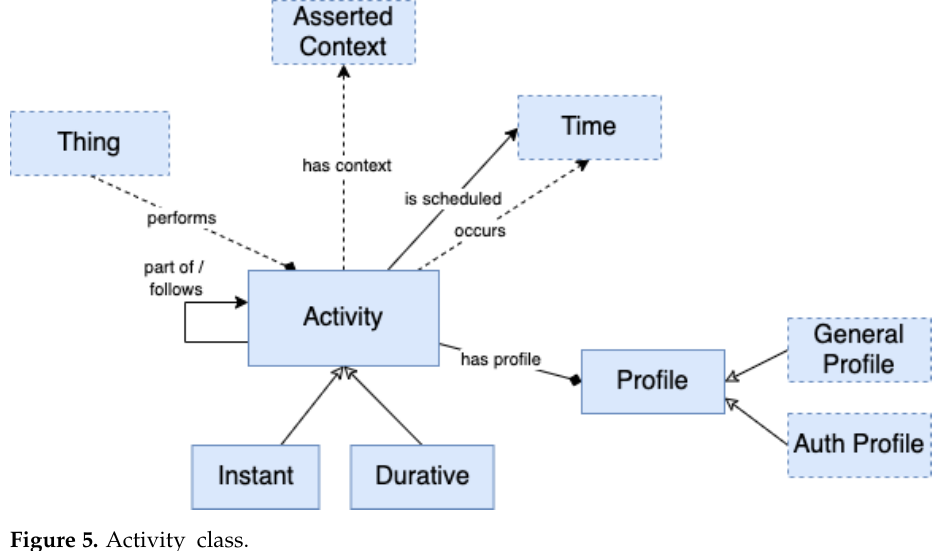
Figure 5. Activity